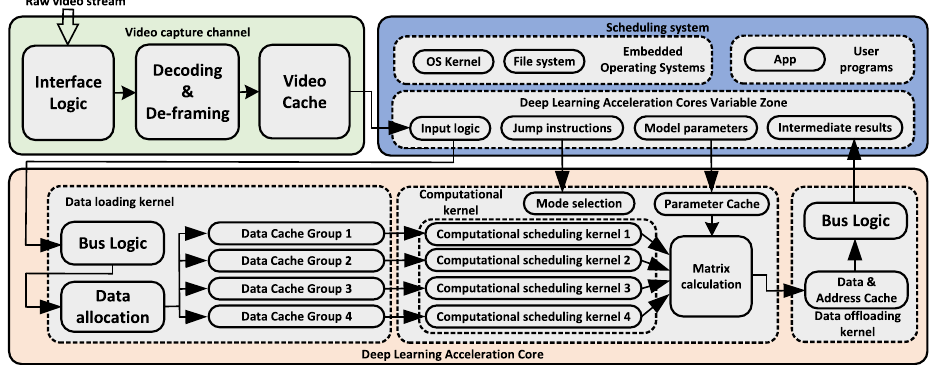
Figure 1. The architecture consists of three parts, the first part is the video capture channel, the second part is the deep learning acceleration core, the third part is the scheduling